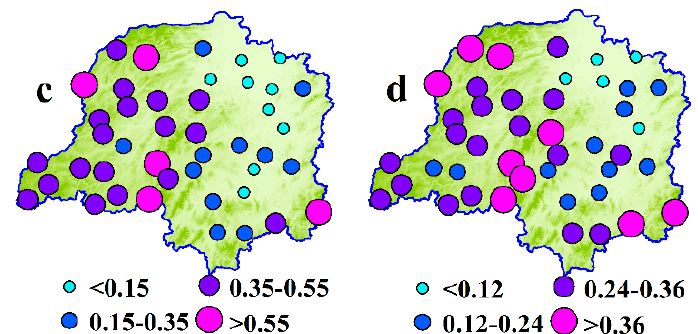
Figure 5. Distribution of the ME ( a ), SE ( b ), MS ( c ) and SS ( d ).